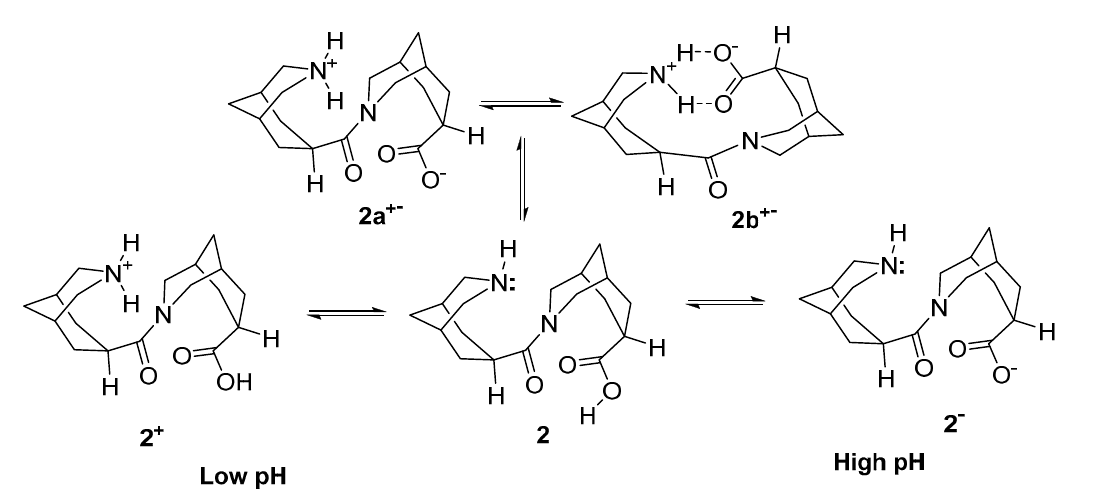
Figure 8. Equilibria established in solutions of 2 at different pH.